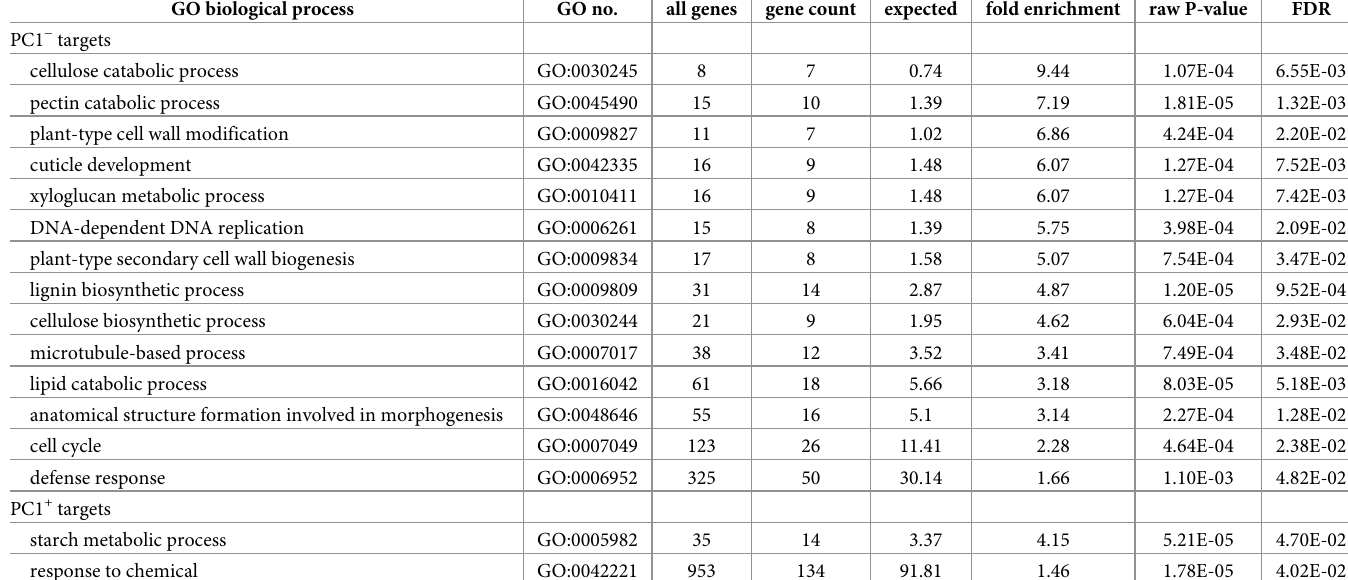
Table 2. Functional categories overrepresented among the top-scoring targets of principal component 1. GO biological process GO